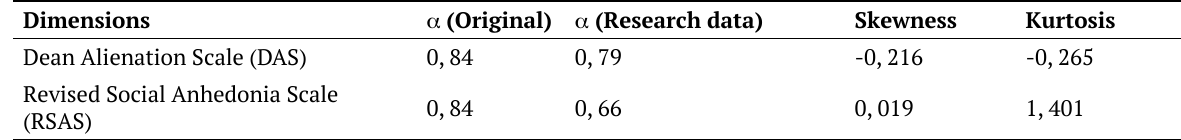
Table 2. Reliability and normality values of the Alienation Scale and the Social Anhedonia Scale